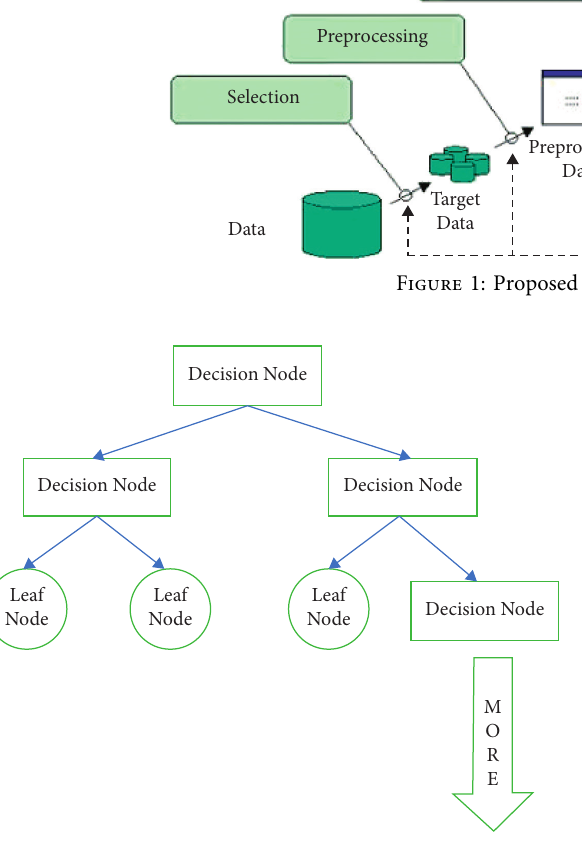
Figure 2: CART flow chart.